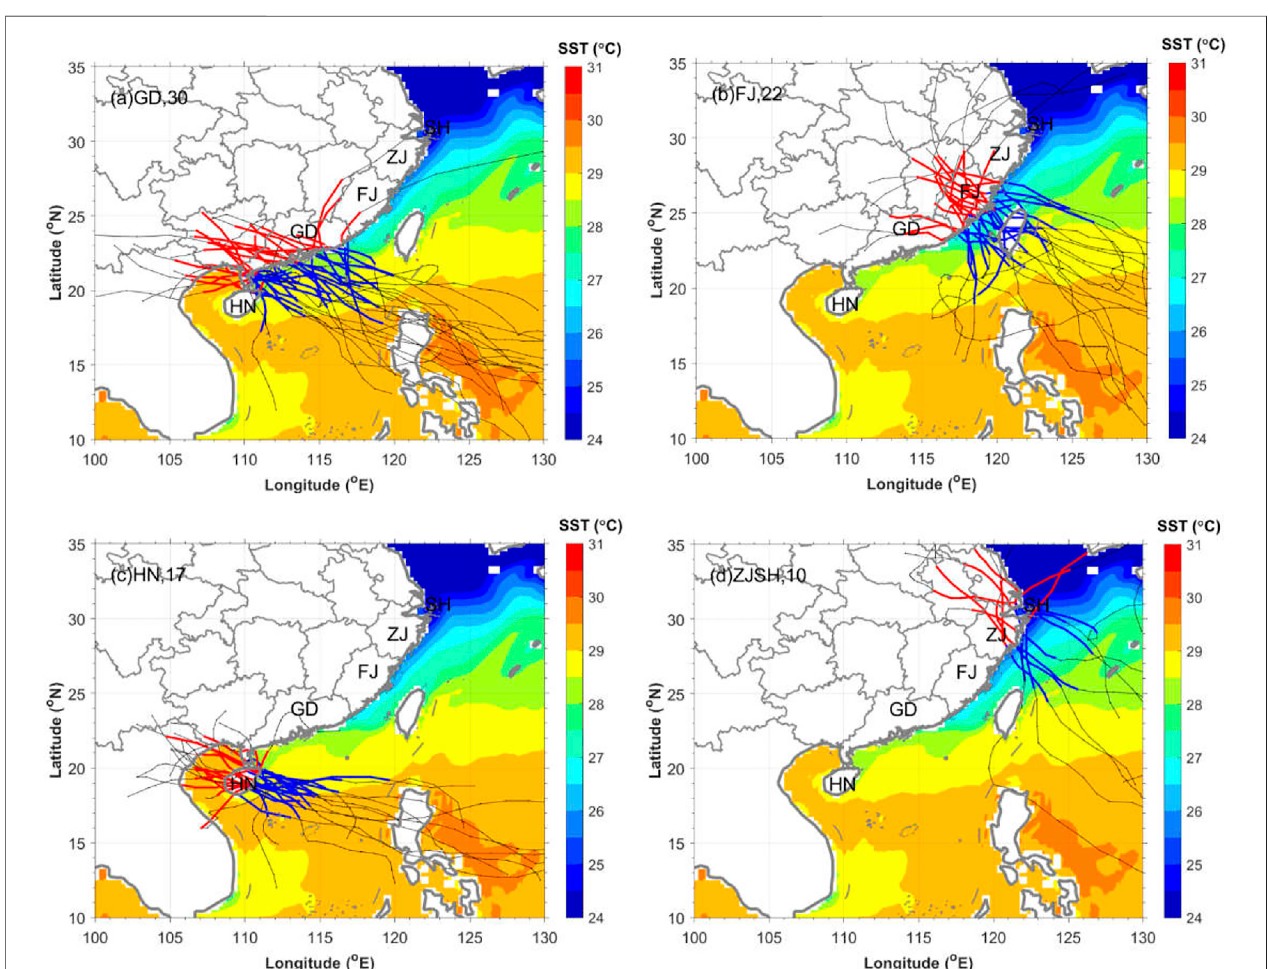
FIGURE 1 | Best tracks and samples of tropical cyclones that made landfall in different regions over China from 2010 to 2020 overlaid with SST. (A) Guangdong (GD), (B) Fujian (FJ), (C) Hainan (HN), and (D) Zhejiang and Shanghai (ZJSH). The blue lines indicate the tracks 24 h prior tolandfall, the red lines indicate the tracks 24 h afterlandfall,andtheblacklinesindicatethetracksbeyondthe48-hlandfallperiod.Thenumbersinthe fi gureindicatethelandfallsamplesinthatregion.SSTdataarethe mean value for the TC season (June to October) in 1989 – 2019 from the ERA5 database.